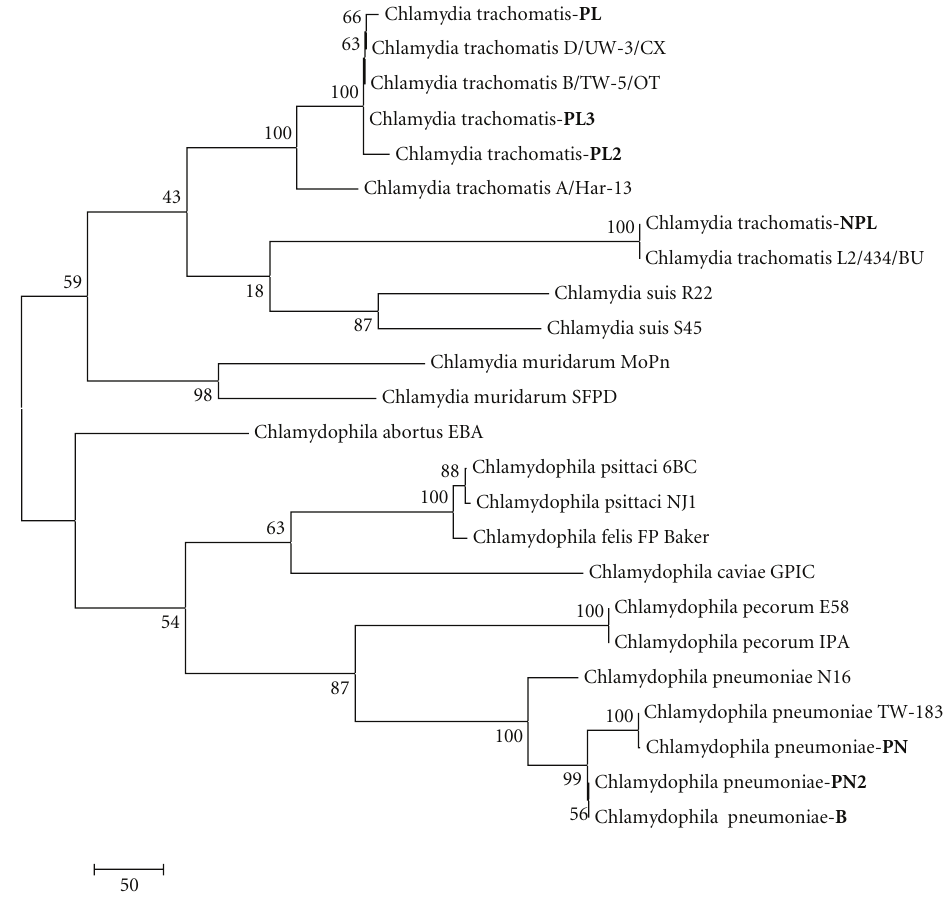
Figure 3: Dendrogram resulted from phylogenetic analysis of middle fragment of 16S–23S rRNA genes and 23S rRNA area of Chlamydia strains I segment by means of Maximum Parsimony method with execution of Bootstrap Test of Phylogeny (1000 repetitions). Strains being under investigation: Chlamydophila pneumoniae (PN: monkey strain, PN2: human strain, and B: reference strain) and Chlamydia trachomatis (PL: plasmid strain released from monkeys, PL2: plasmid strain released from humans, and PL3: reference strain and NPL- nonplasmid strain released from